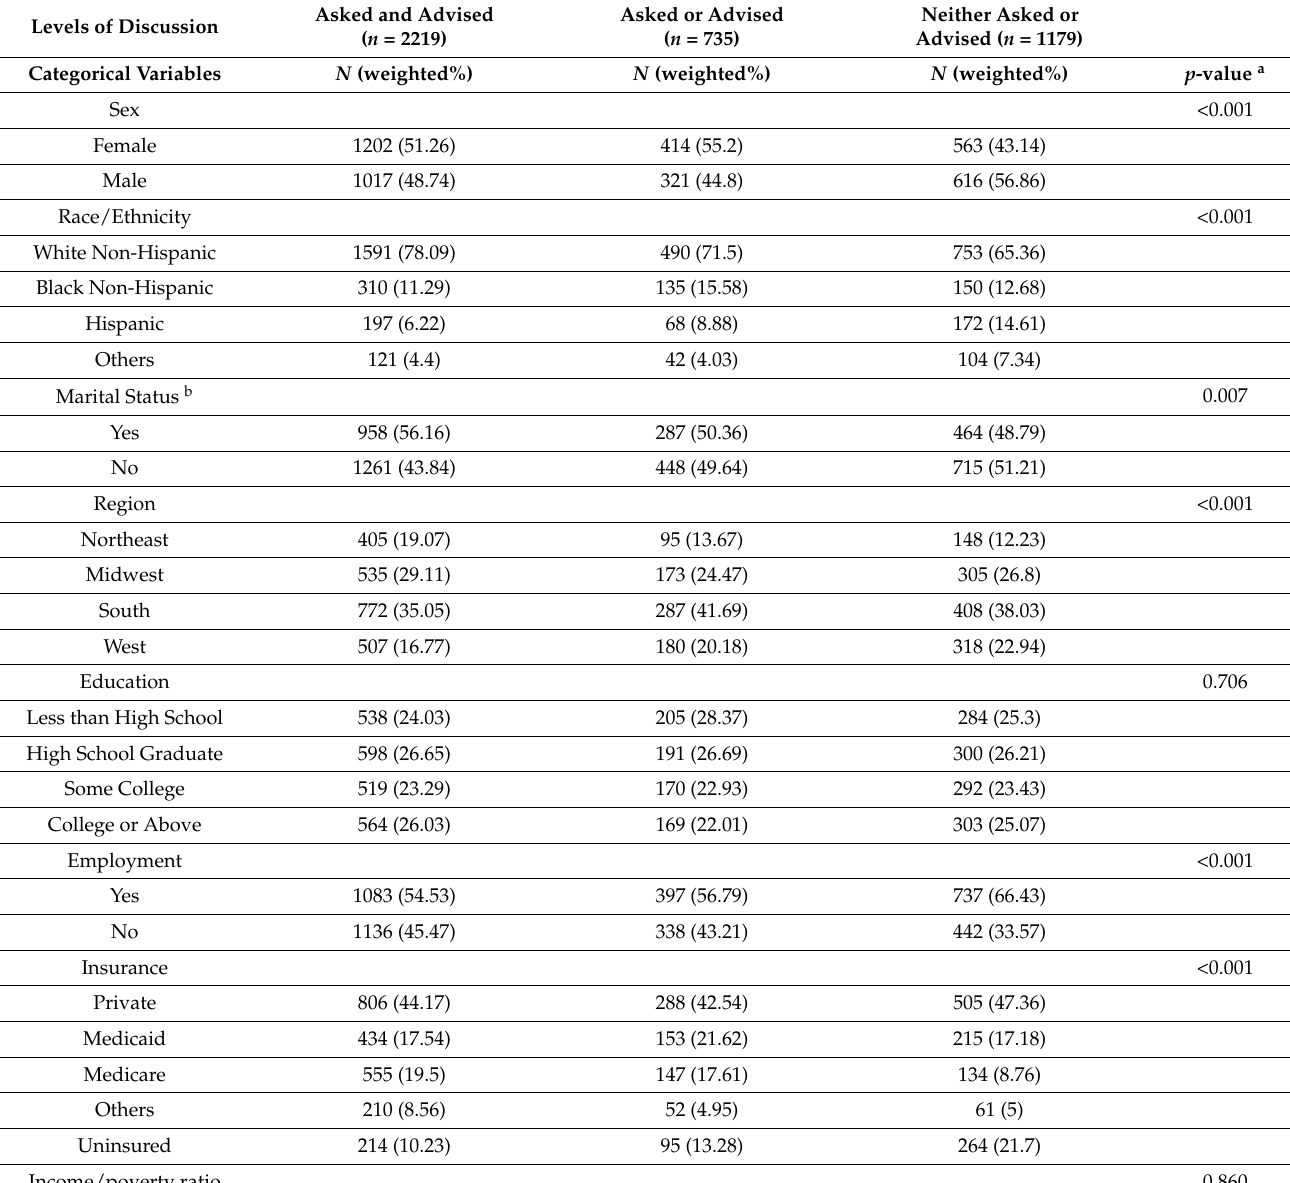
Table 1. Characteristics of the study sample by the level of provider–patient discussion, 2015